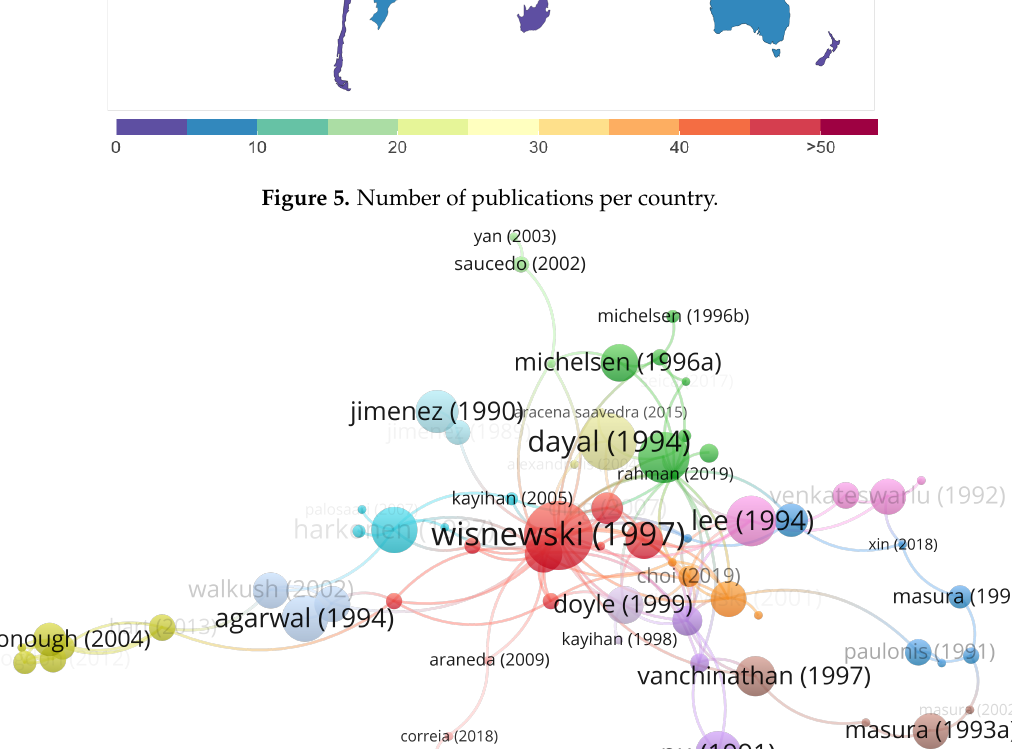
Figure 6. The network map showing the relationships between various publications based on